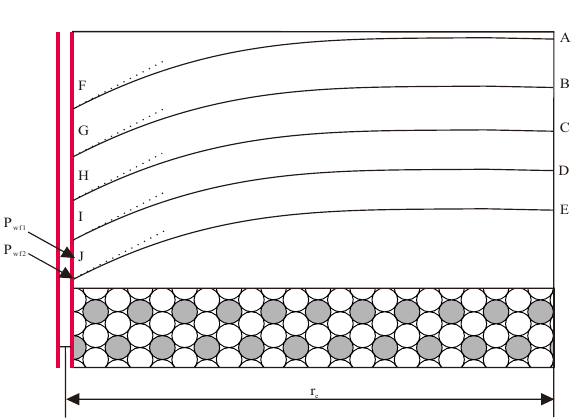
Fig. 10 Pressure profile of the